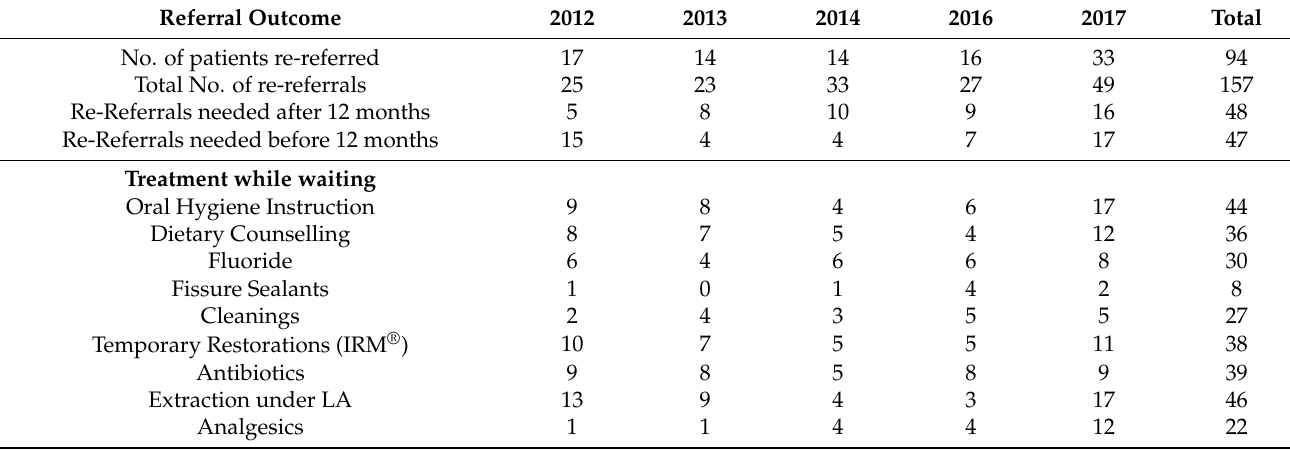
Table 5. Referral and type of treatment received while awaiting GA/sedation